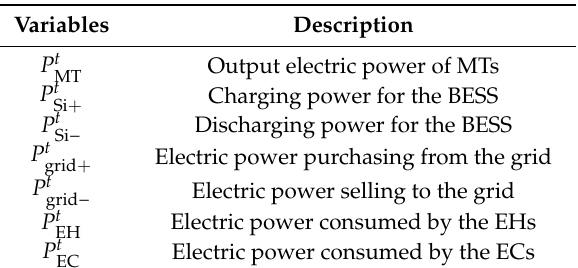
Table 1. Control variables.